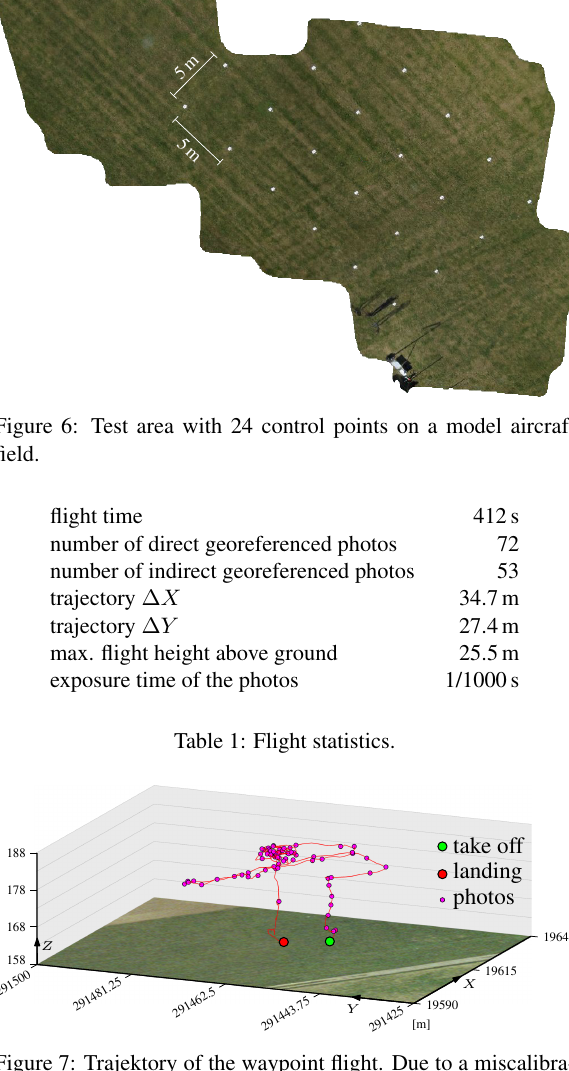
Figure 7: Trajektory of the waypoint flight. Due to a miscalibra- tion of the magnetometer the waypoint flight was stopped and the final flight and landing was performed